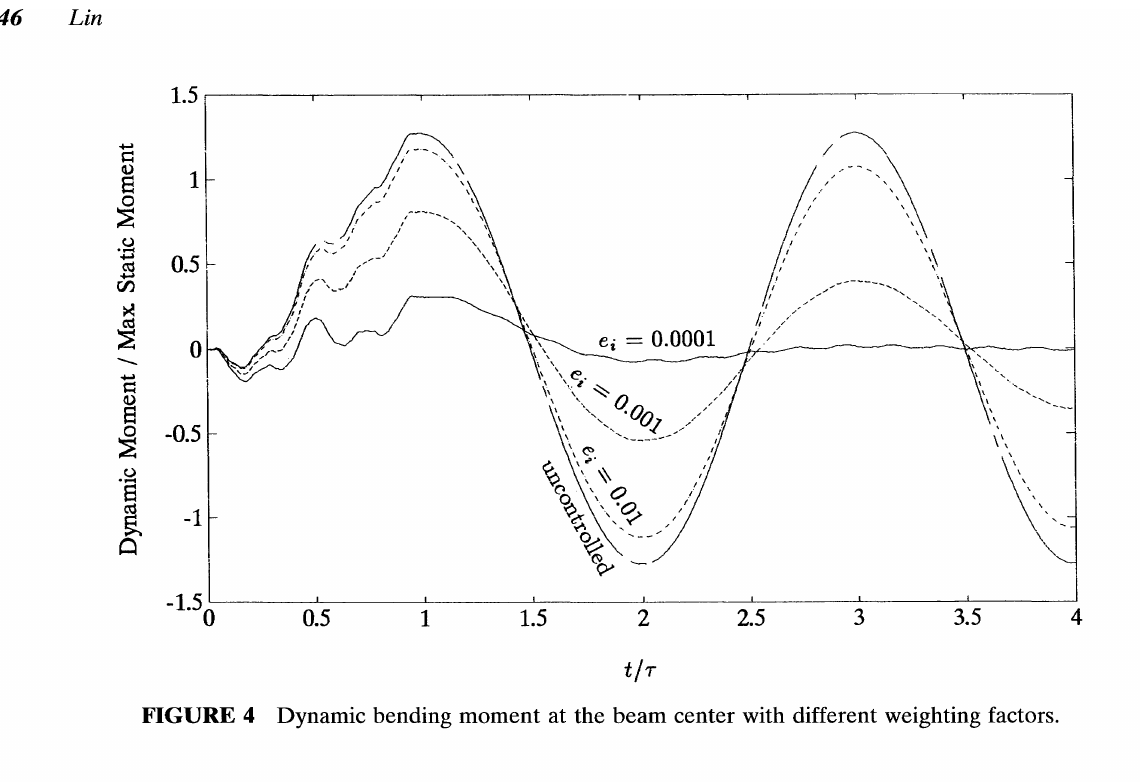
FIGURE 4 Dynamic bending moment at the beam center with different weighting factors.